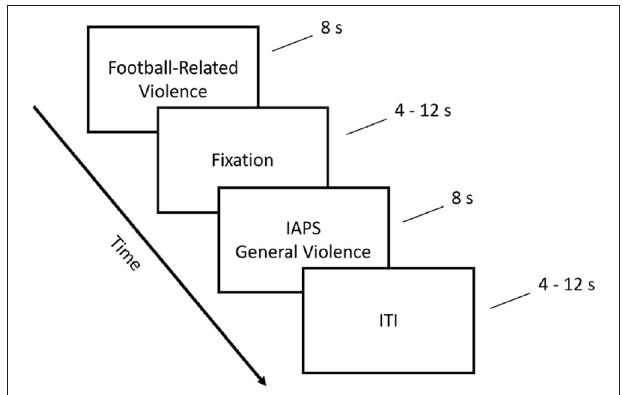
FIGURE 1 | Viewing task. The experimental procedure used by all participants while in the MRI